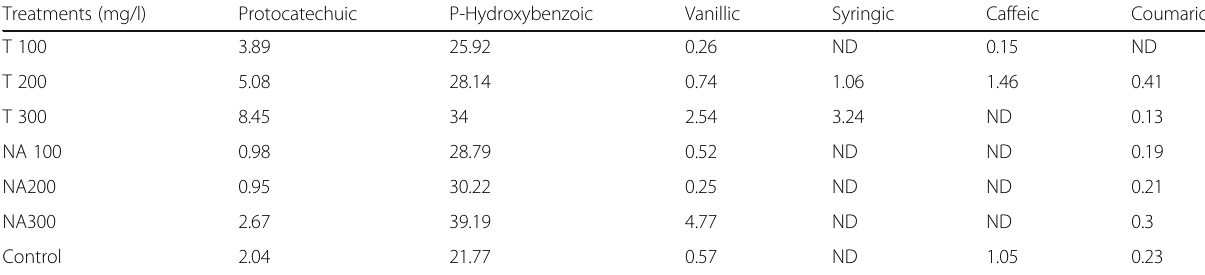
Table 5 Effect of tryptophan and nicotinamide on phenolic acids of guar seeds Treatments